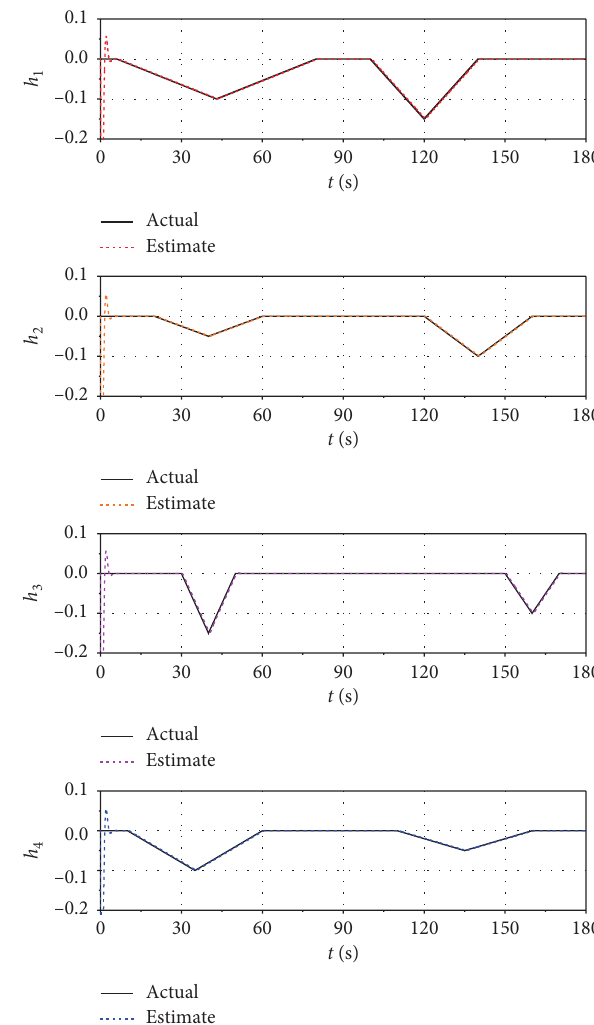
Figure 3: The estimation of health parameters for Type I.